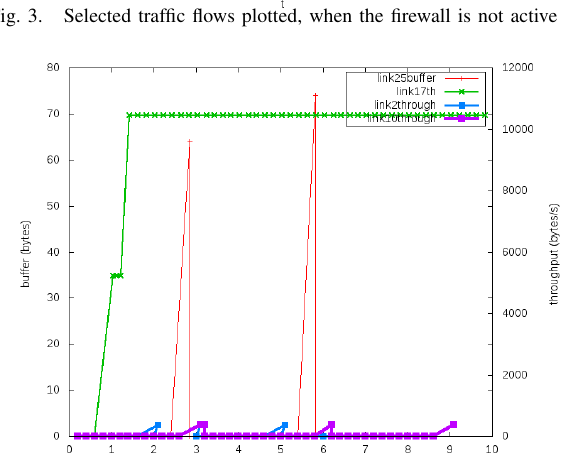
Fig. 4. Selected traffic flows plotted, when the firewall is active